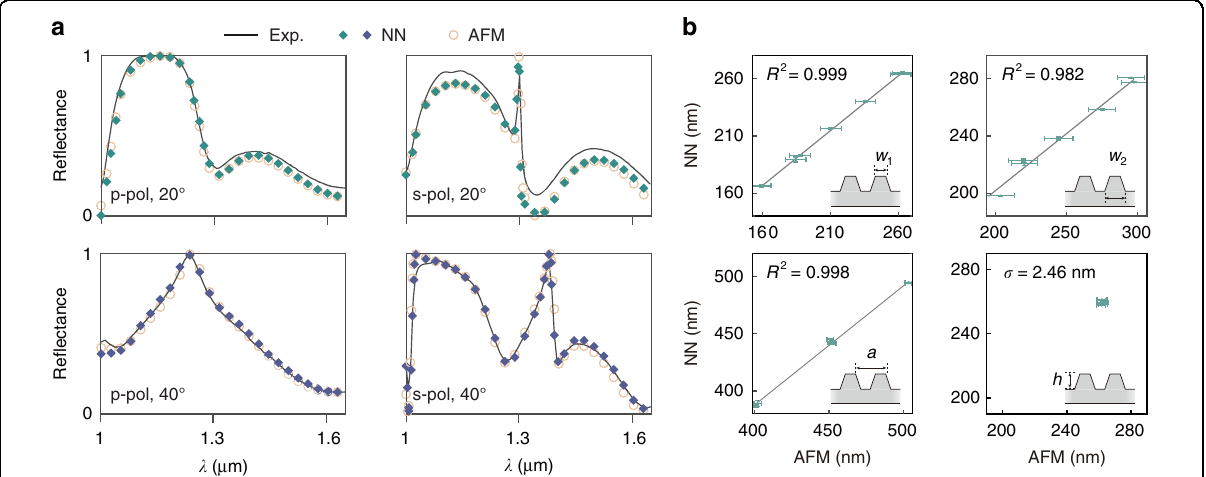
Fig. 4 Reconstruction results of experimental data. a Detailed comparisons of photonic dispersions: measured by ARS, generated by forward- mapping NN using optimal parameters, and simulated by RCWA using AFM measured parameters. Spectra at two incident angles (20° and 40°) with p/s-polarizations are plotted. b Correlations between the results of forward-mapping algorithm (green marks) and AFM measurements (gray line). Error bars are 1